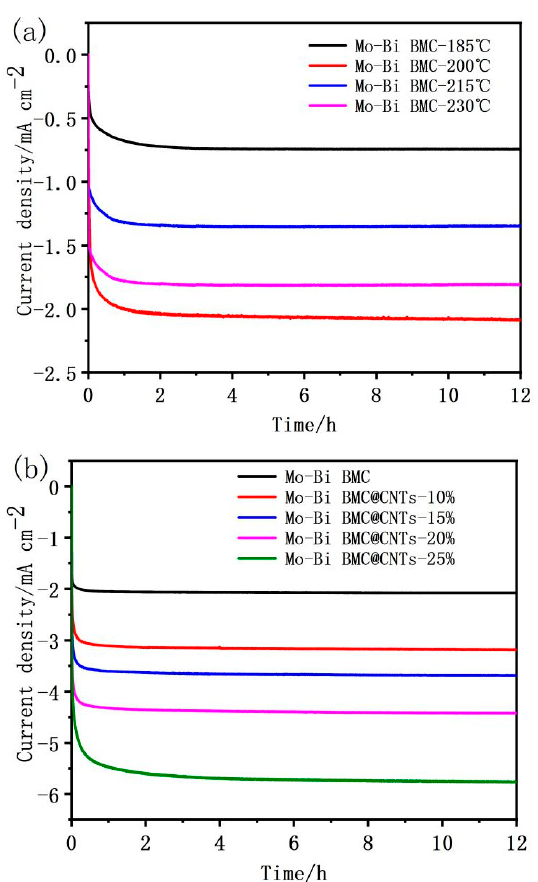
Figure 8. A 12 h long-term CA at − 0.30 V over Mo–Bi BMC ( a ) and Mo–Bi BMC@CNTs ( b ).